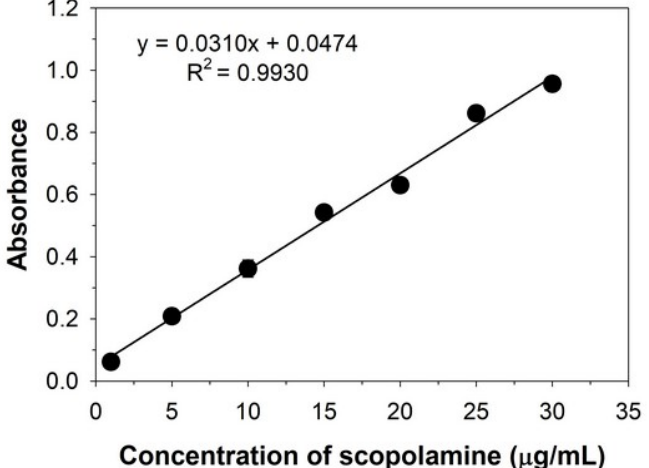
± standard deviation, n =